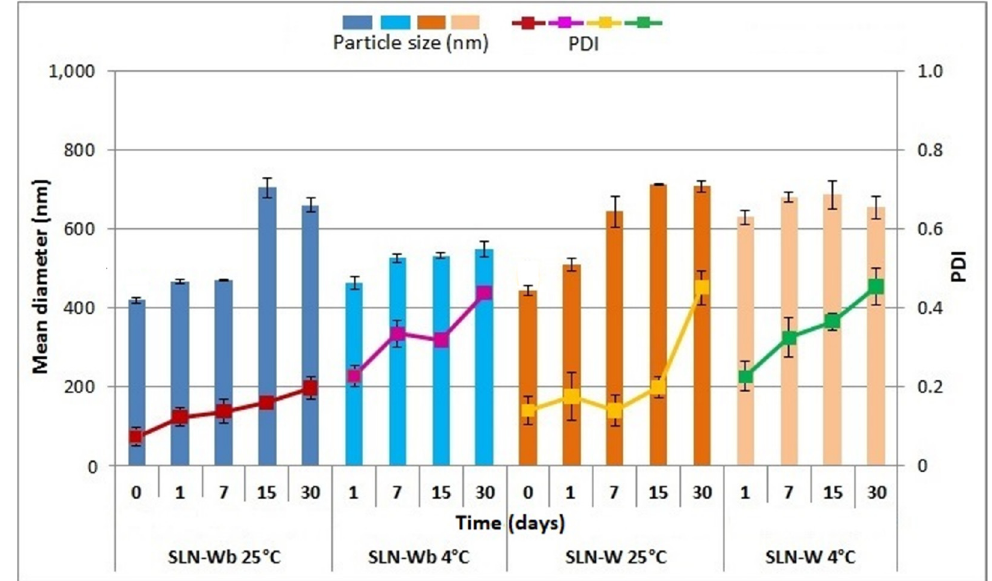
Figure 9. Influence of storage (at 4 and 25 °C) on the particle size and PDI of SLN-Wb and SLN-W. Particle size: SLN-Wb at 25 °C, 0 days vs. 15 and 30 days ( p < 0.05); SLN-Wb at 4 °C, 0 days vs. 7, 15 and 30 days ( p < 0.05); SLN-W at 25 °C, 0 days vs. 7, 15 and 30 days ( p < 0.05); SLN-W at 4 °C, 0 days vs. 1, 7, 15 and 30 days ( p < 0.05). PDI: SLN-Wb at 25 °C, 0 days vs. 7, 15 and 30 days ( p < 0.05); SLN-Wb at 4 °C, 0 days vs. 1, 7, 15 and 30 days ( p < 0.05); SLN-W at 25 °C, 0 days vs. 30 days ( p < 0.05); SLN-W at 4 °C, 0 days vs. 7, 15 and 30 days ( p < 0.05).